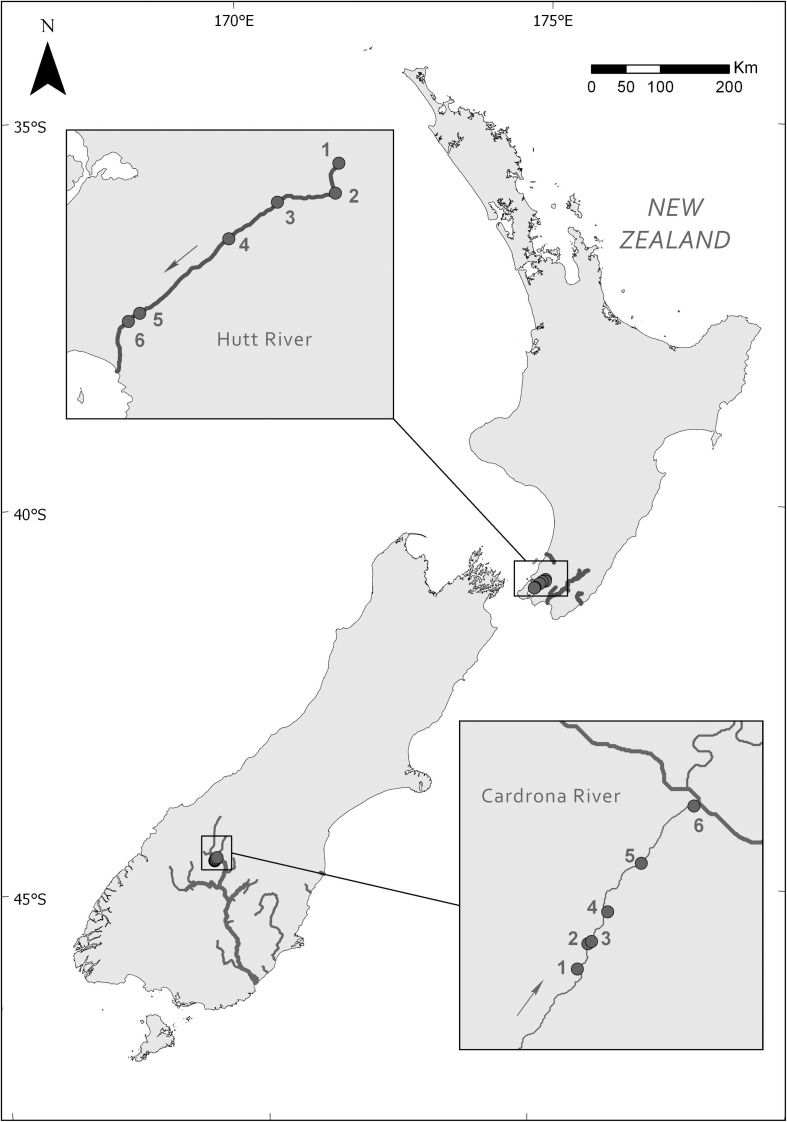
Locations of the six study sites along the Hutt River (Wellington) and Cardrona River (Otago), New Zealand. Arrows indicate the direction of river flow.